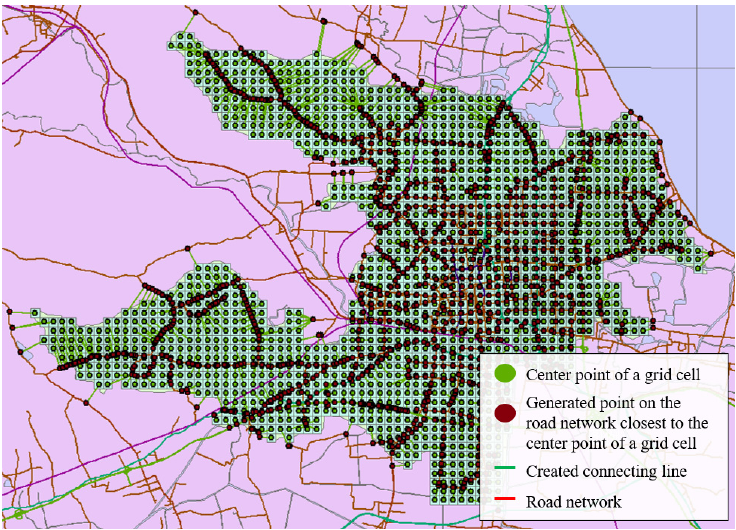
Figure 6. Zhicheng’s road network model.